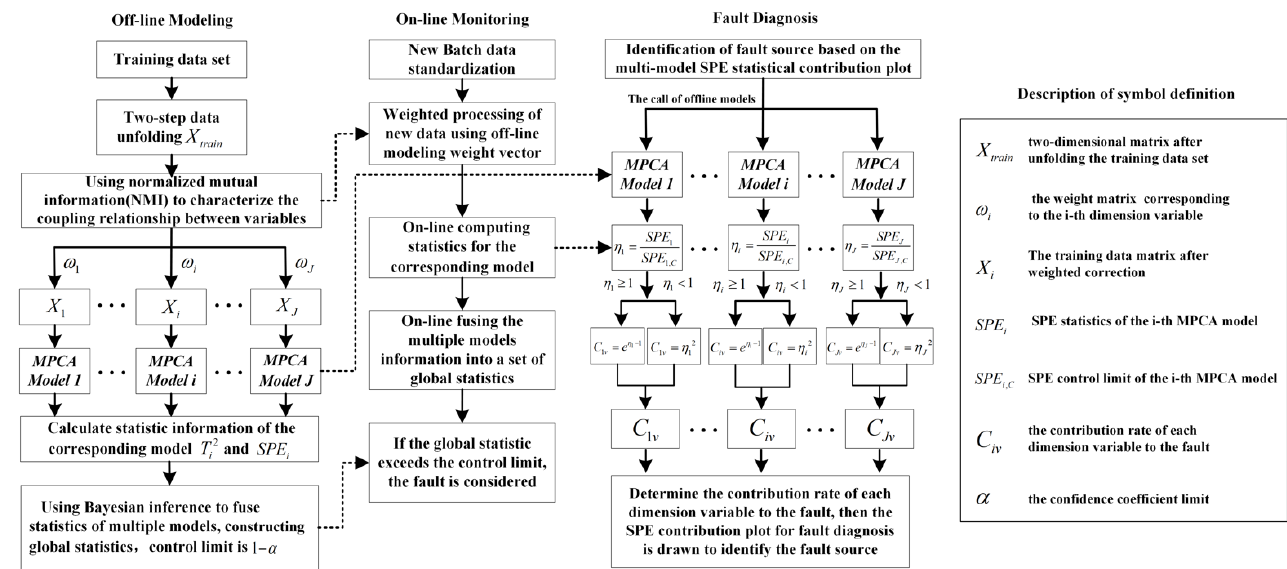
Figure 3. Flowchart of the fault detection and diagnosis based on the NMI-WMPCA method. 4.1. Establish the NMI-WMPCA Model under Normal Working Conditions (Offline Modelling)